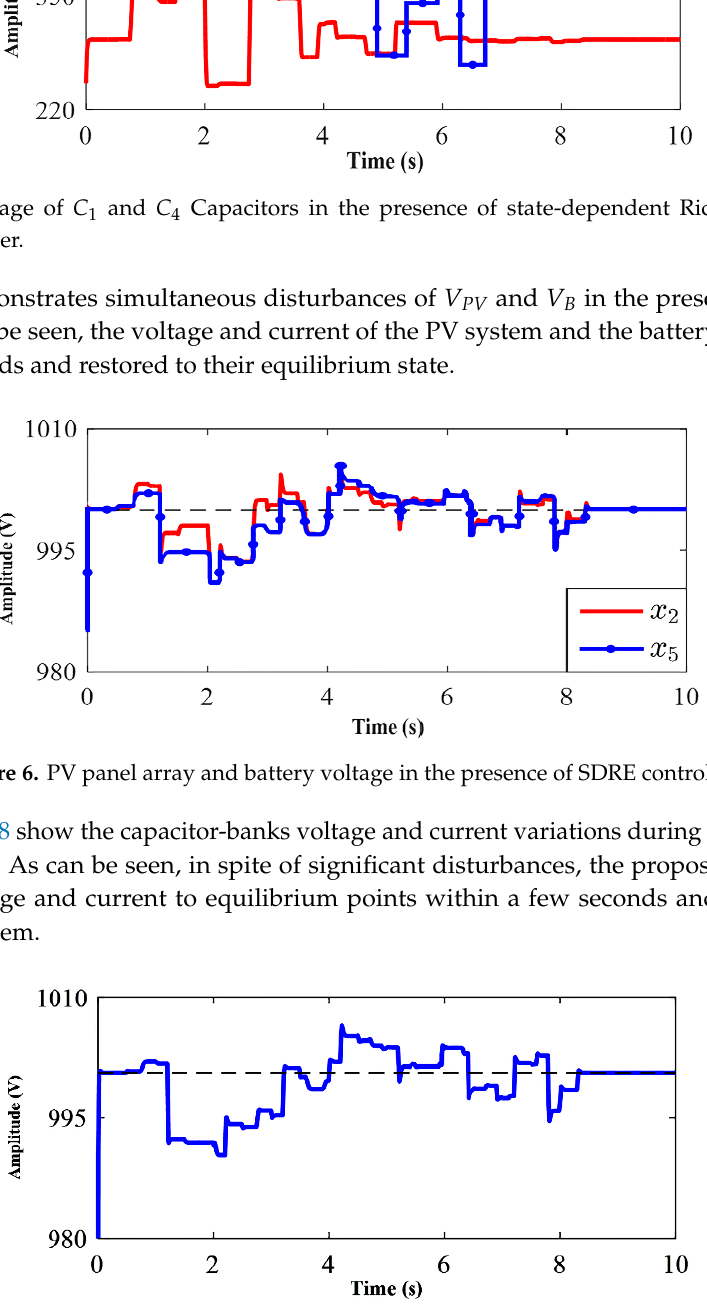
Figure 4. PV voltage (Vpv) battery storage voltage ( V B ) and load variation.